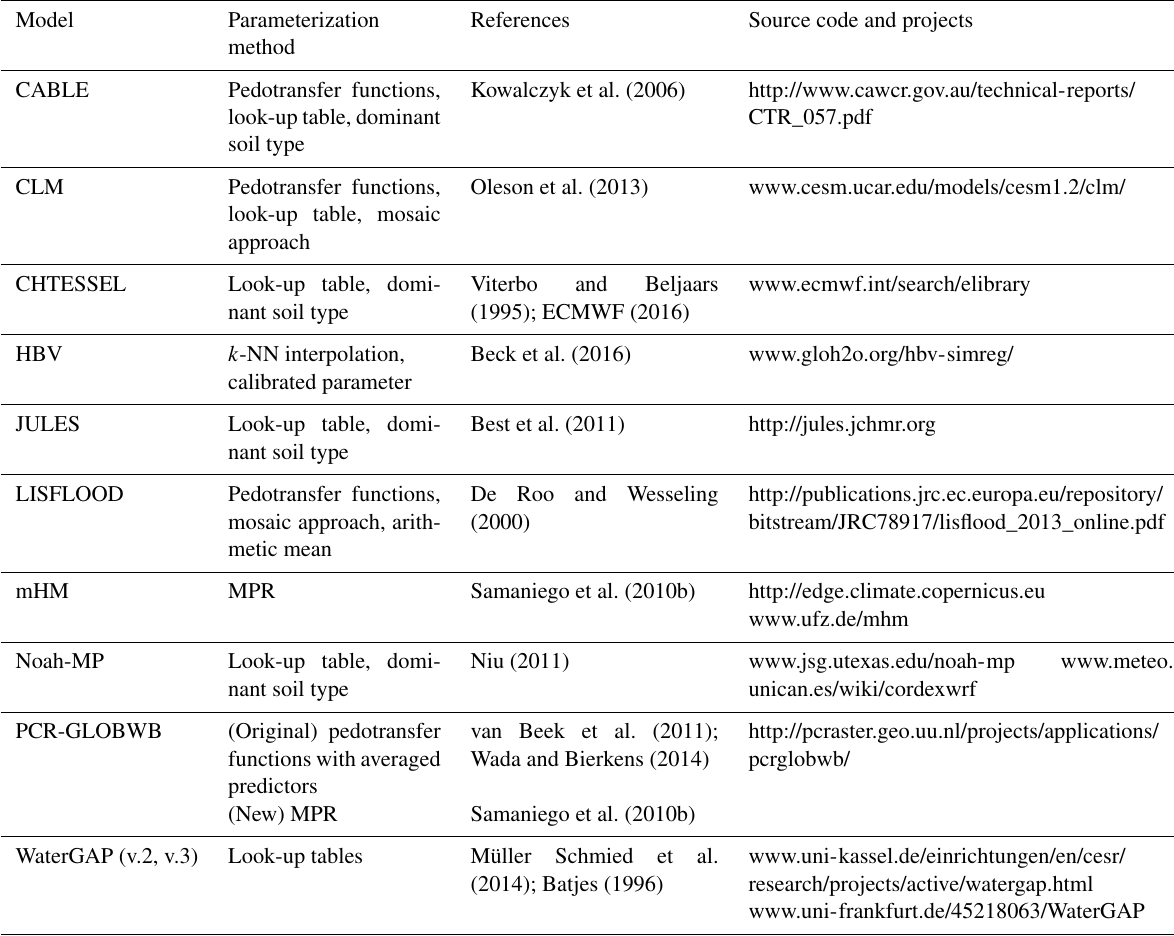
Table 1. Data sources and parameterization methods used by models used in this study.